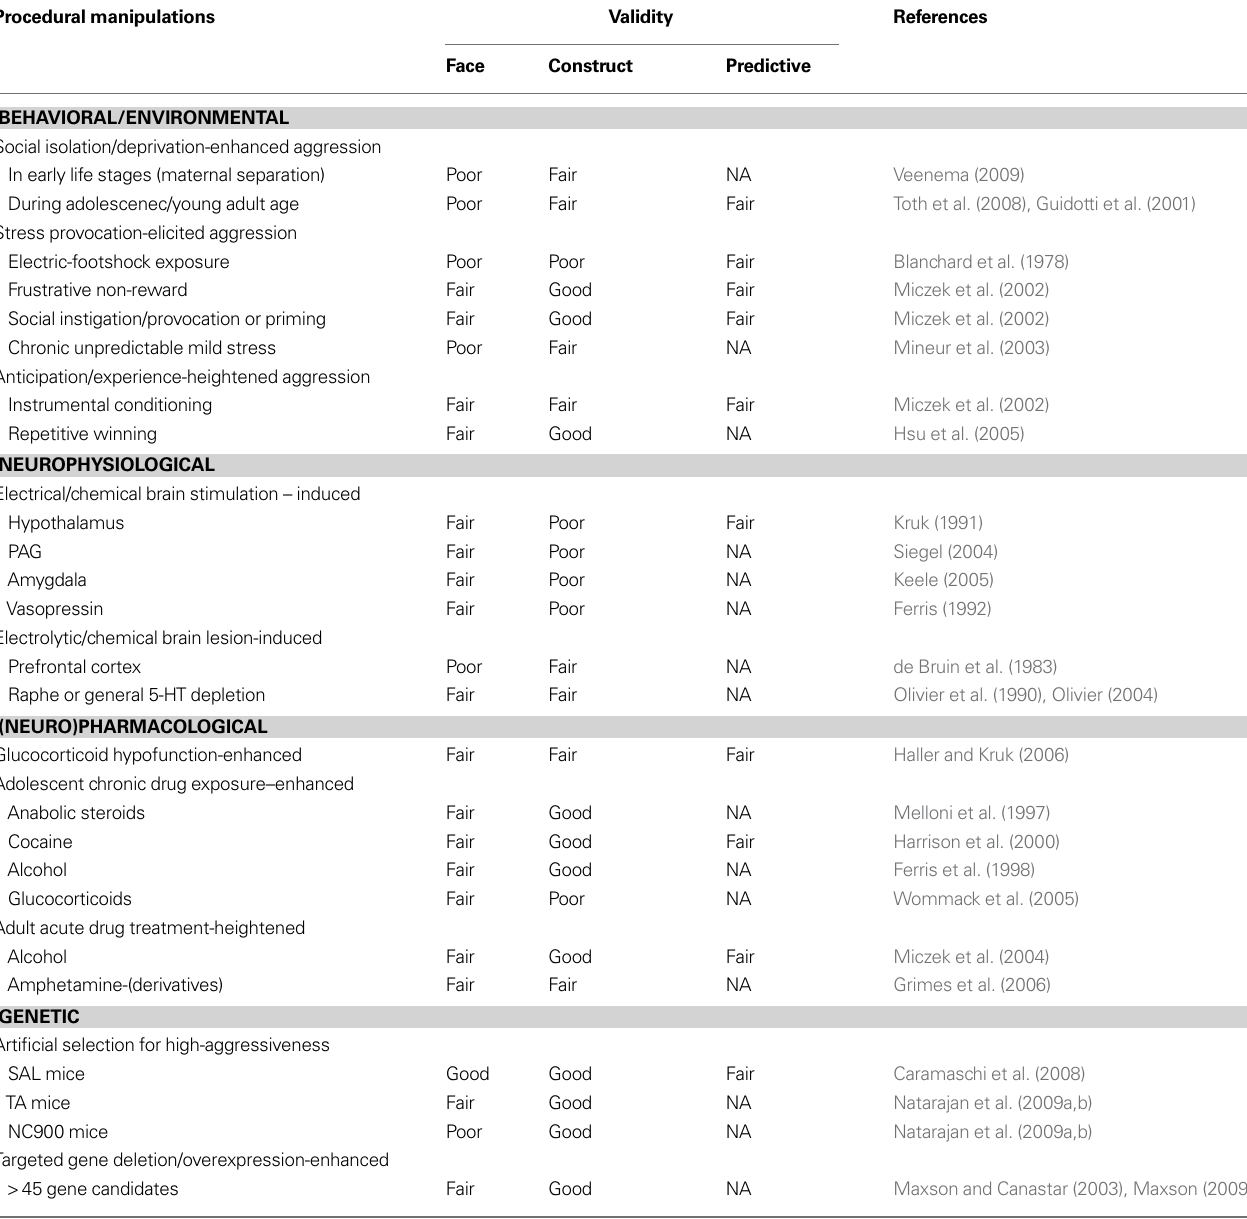
Table 1 | Procedural manipulations to induce increased levels or pathological forms of aggressive behavior in experimental animals (rats, mice and